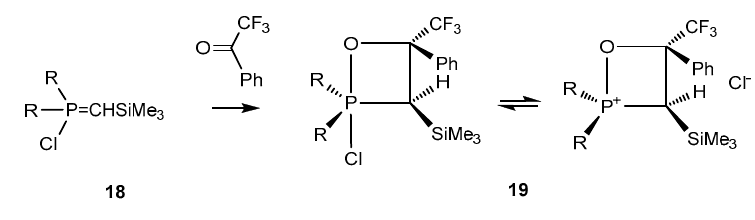
Table 1. 2-Chloro- and 2-bromo-1,2 λ 5 -oxaphosphetanes.